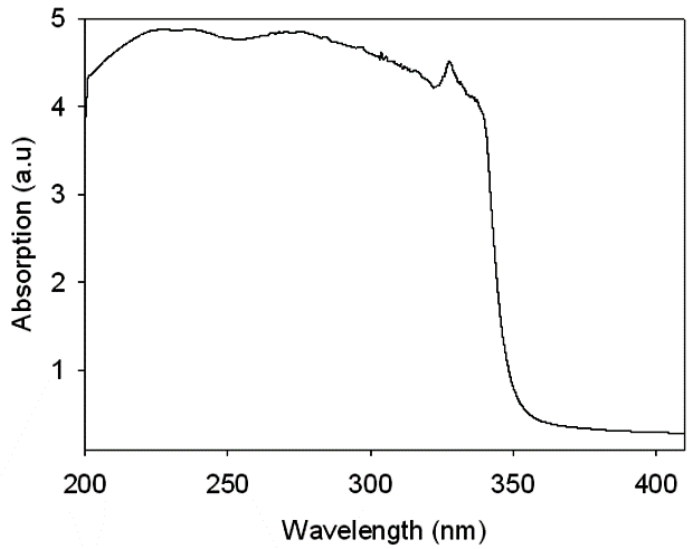
Figure 2. UV spectrum of WBPU-PDMS-Ce film.